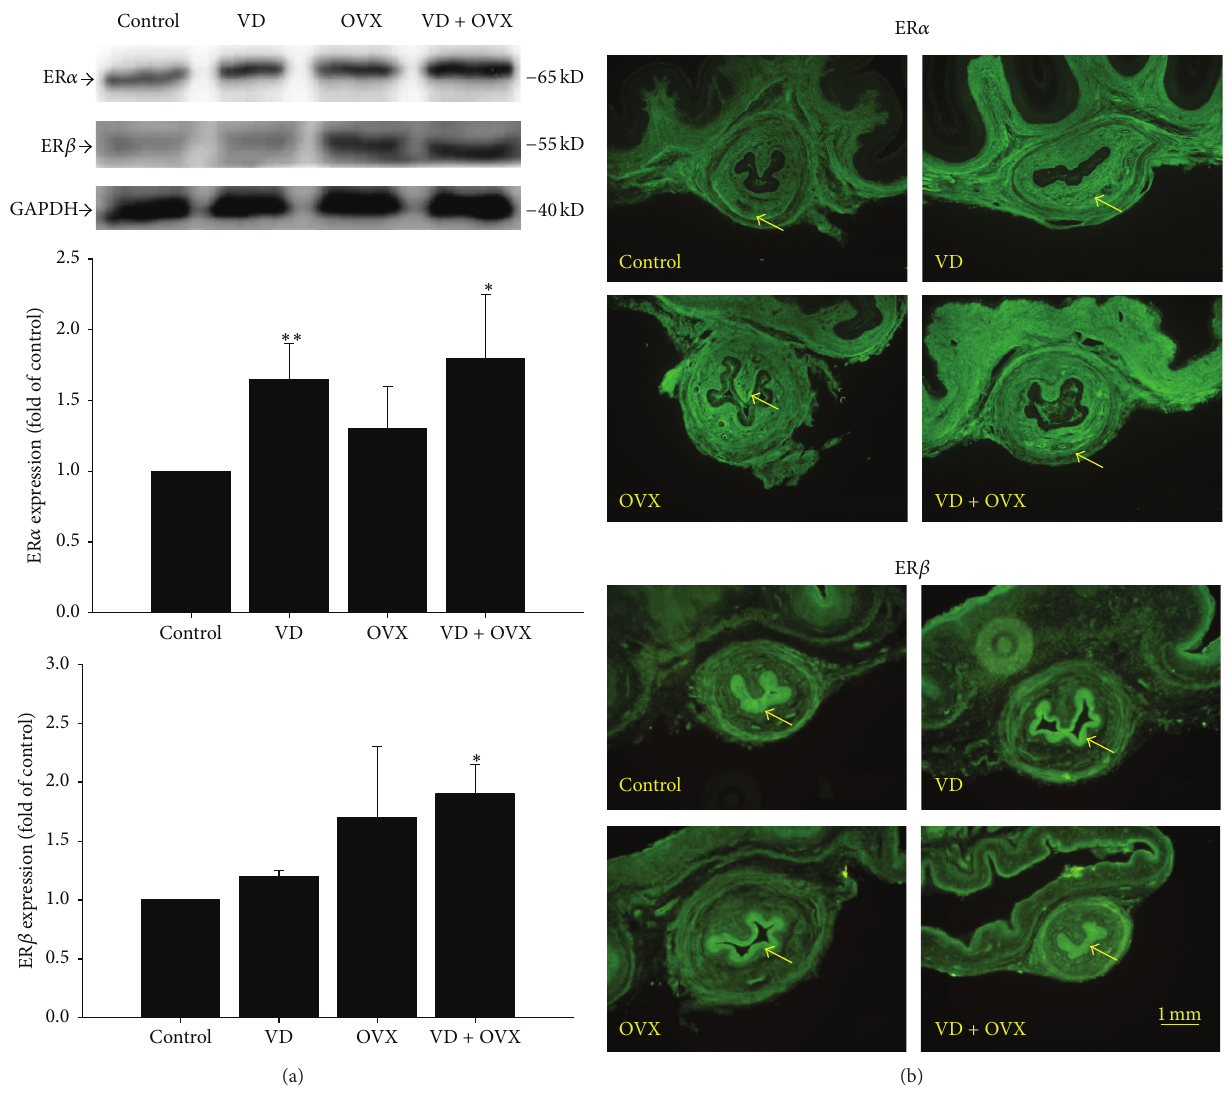
Figure 5: ER 𝛼 and ER 𝛽 expressions in the transverse sections of the midurethra as indicated by (a) Western blot and (b) immunofluorescence staining in the different groups. The values are calculated by fold of control and expressed as mean ± SEM of six individual mice. ∗ 𝑃 < 0.05 compared to control group; ∗∗ 𝑃 < 0.01 compared to control